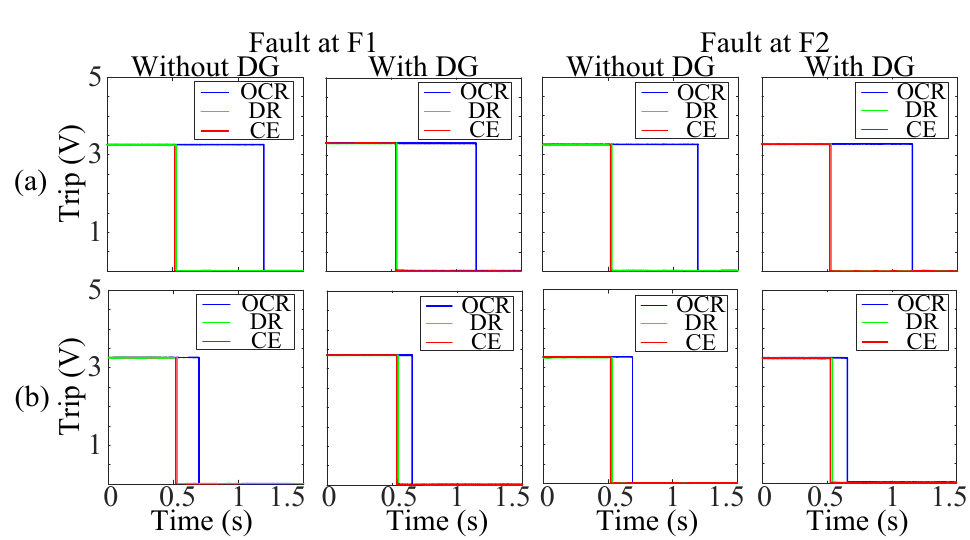
Figure 10. Digital output of OCR, DR, and CE-ZO with DG during a ( a ) single-phase fault, and ( b ) three-phase fault.